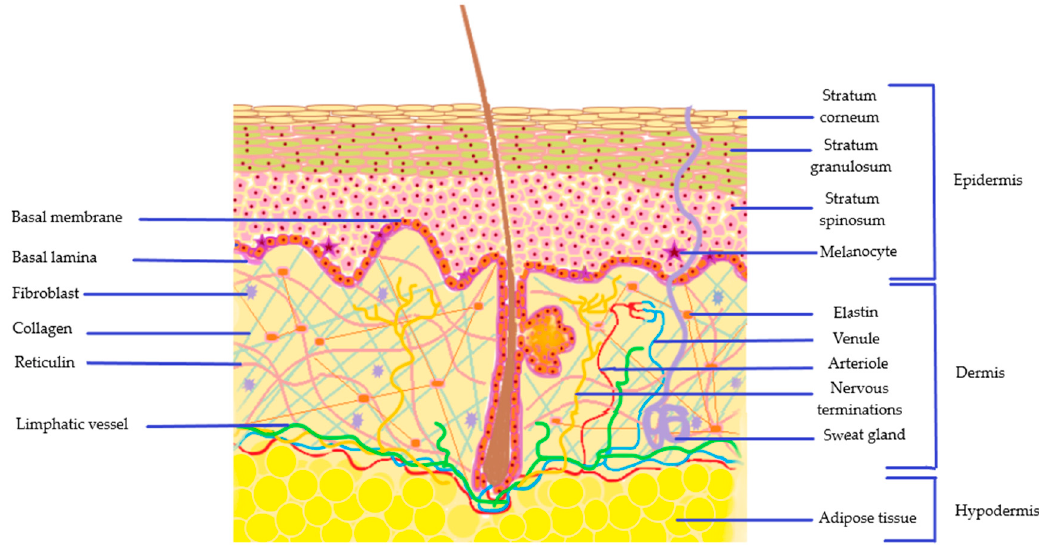
Figure 2. Anatomical structure of skin with the most important components of epidermis, dermis and hypodermis